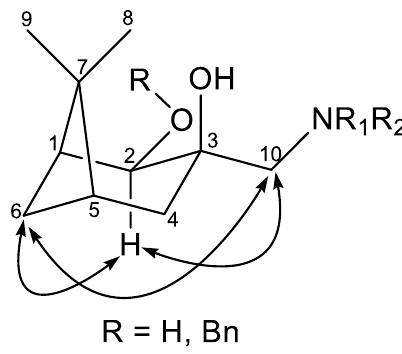
Figure 1. Determination of the structure of aminodiols by NOESY .